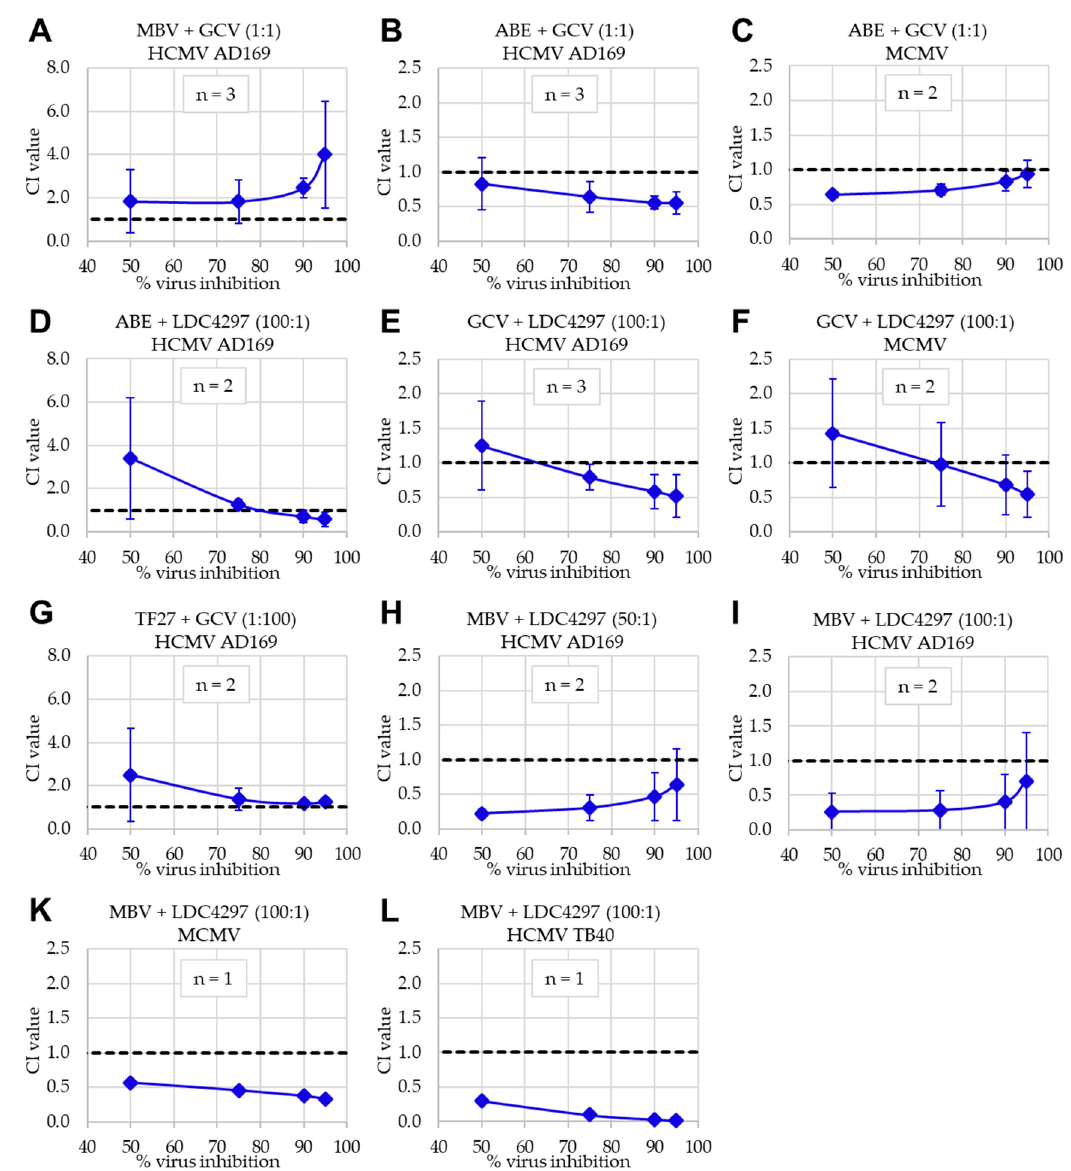
Figure 6. Loewe additivity fixed-dose assay results. Numbers in brackets indicate fixed ratio of drugs in the respective combination. ( A ) MBV + GCV (1:1) against HCMV in HFFs; ( B ) ABE + GCV (1:1) against HCMV in HFFs; ( C ) ABE + GCV (1:1) against MCMV in MEFs; ( D ) ABE + LDC4297 (100:1) against HCMV in HFFs; ( E ) GCV + LDC4297 (100:1) against HCMV in HFFs; ( F ) GCV + LDC4297 (100:1) against MCMV in MEFs; ( G ) TF27 + GCV (1:100) against HCMV in HFFs; ( H ) MBV + LDC4297 (50:1) against HCMV in HFFs; ( I ) MBV + LDC4297 (100:1) against HCMV in HFFs; ( K ) MBV + LDC4297 (100:1) against MCMV-UL97 in MEFs. ( L ) MBV + LDC4297 (100:1) against HCMV TB40 in ARPE-19 cells. Data are presented as mean CI values ± SD, extrapolated to 50%, 75%, 90% and 95% virus inhibition across the number of individual experiments ( n = 1 to n = 3).